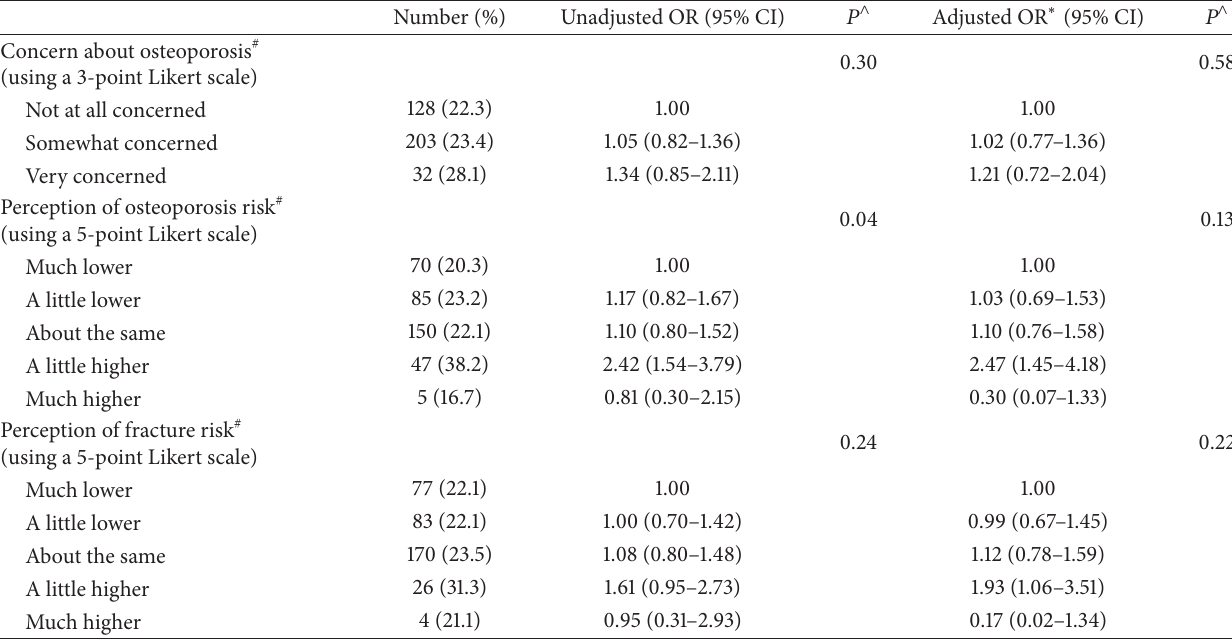
Table 2: Odds ratio (ORs) of calcium and/or vitamin D use in the next 12 months for covariates about concern and risk perception of osteoporosis (limited to assessments with noncurrent use of calcium or vitamin